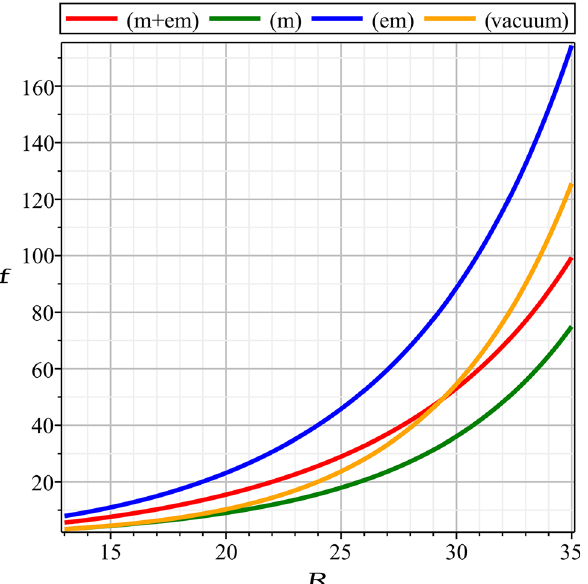
Fig. 6 This figure demonstrates the plot of f ( R ) for four options of interest (1- Pure electromagnetic case (blue color); 2- Pure matter case (green color); 3- Both electromagnetic and matter cases (red color); 4-